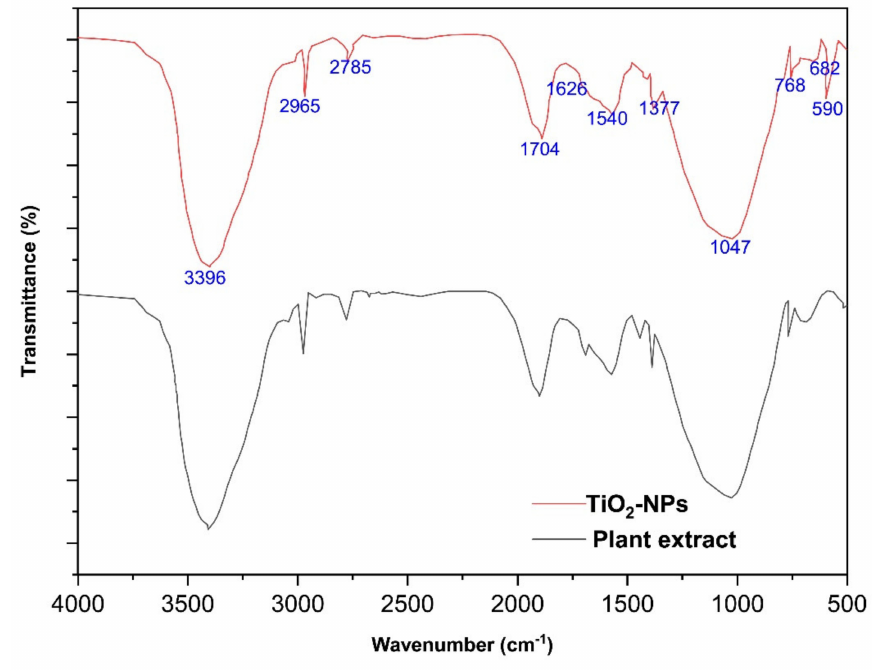
Figure 2. FTIR spectra of TiO 2 NPs prepared by green synthesis.